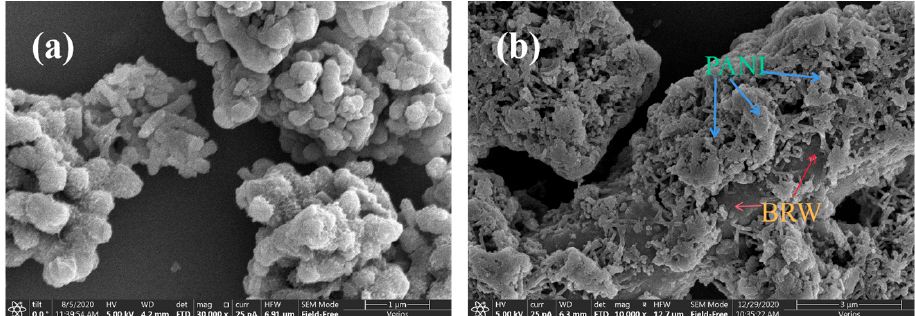
Figure 3. SEM images of ( a ) PANI, ( b ) PANI@BRW (mass ratio, An/BRW =